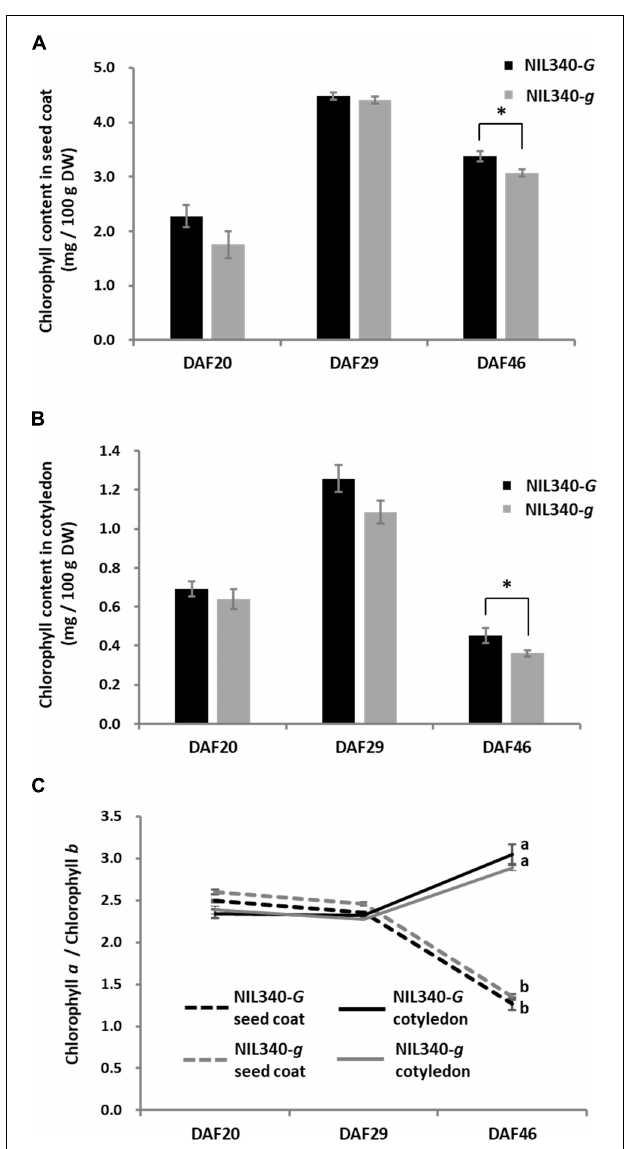
FIGURE 5 | Characterization of seed coats and cotyledons in NIL340s (green cotyledons). (A) Chlorophyll content of the seed coat. ∗ indicates the significant differences between NIL340- G and NIL340- g at the 5% level. (B) Chlorophyll content of the cotyledon. ∗ indicates the significant differences between NIL340- G and NIL340- g at the 5% level. (C) Composition ( a / b ) of the chlorophyll a and b content in seed coats and cotyledons. Different letters at DAF46 denote significant differences ( P < 0.01). All data shown are the mean ± SD of four